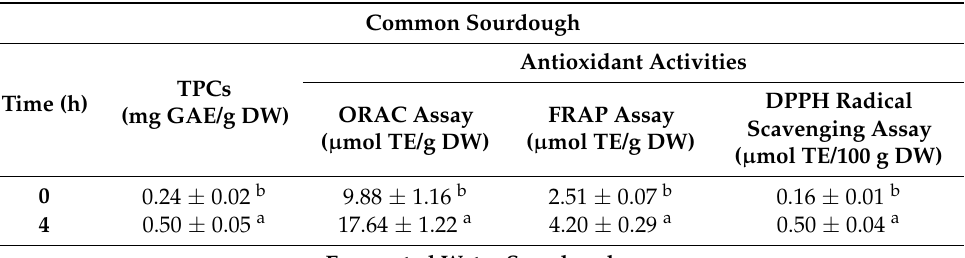
Table 1. Total phenolic contents (TPCs) and antioxidant activities of common sourdough and fer- mented water sourdough fermented at different time periods (0 and 4